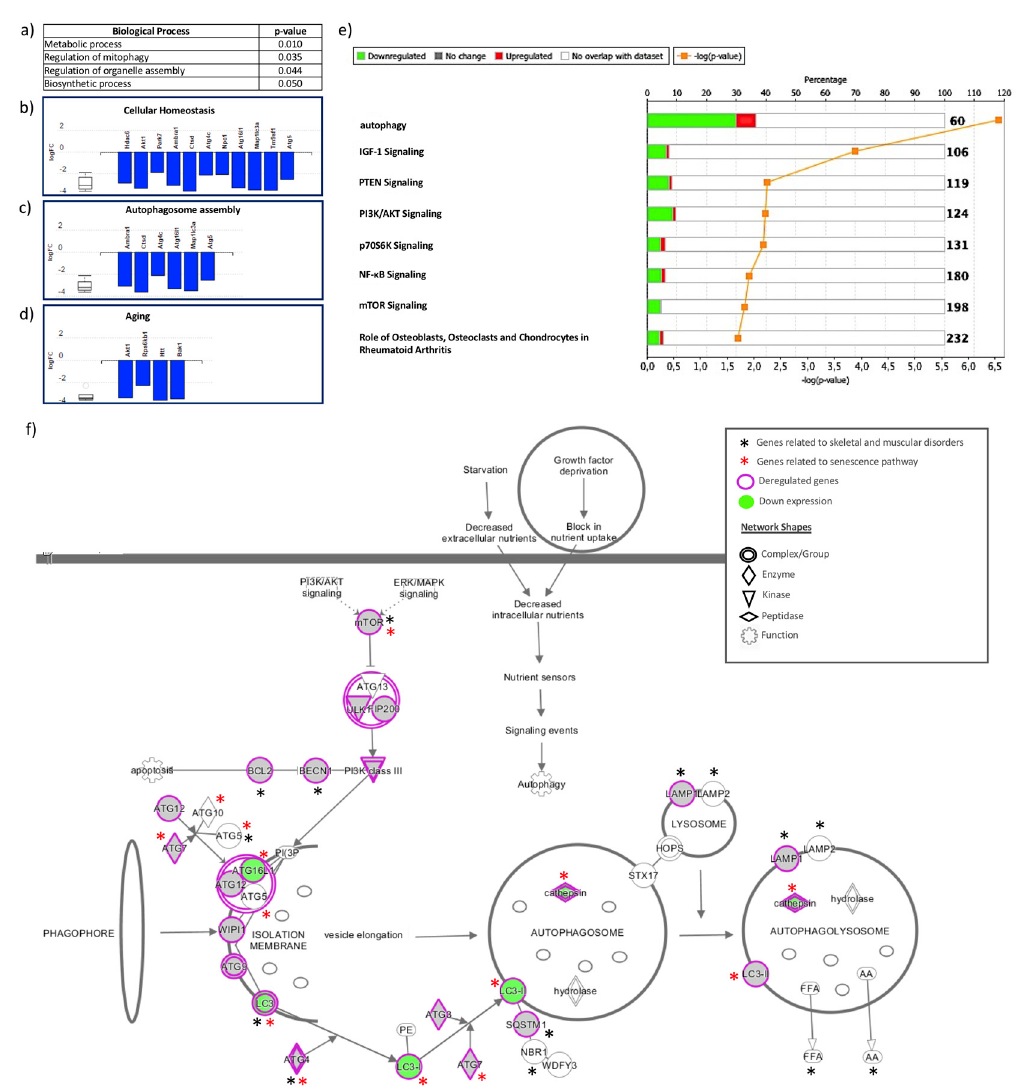
Figure 4. Bioinformatics analysis of biological process terms and pathways among genes related to autophagy in order to explore the biological relevance of the deregulated genes. ( a , d ) Bioinformatics analysis with Advaita Bio’s iPathwayGuide. ( a ) Table for biological process terms that are significantly associated with deregulated genes. ( b – d ) Molecules and their respective fold changes involved in the processes of cellular homeostasis, autophagosome assembly, and aging, respectively. ( e , f ) Bioinformatics analysis with Ingenuity Pathway Analysis. ( e ) Pathways and diseases associated with di ff erentially expressed genes. ( f ) Autophagy pathway, deregulated genes, and overlap with skeletal and muscular disorder and senescence. One of the general ways to activate autophagy begins with growth factor deprivation that blocks the nutrient uptake, and another is starvation that decreases the extracellular nutrients; both stimuli decrease the intracellular nutrients, activate nutrient sensors, and generate signaling events that empower autophagy. The detailed processes are illustrated. The upstream pathways are PI3K (phosphoinositide 3-kinase) / AKT (serine / threonine kinase) signaling and ERK / MAPK signaling, respectively, which are able to regulate mammalian target of rapamycin (mTOR) signaling, a key factor for autophagy. In general, autophagy consists of a series of dynamic membrane rearrangements mediated by a group of proteins related to ATG, where Atg1 (ULK1), Atg6 (Beclin1), Atg8 (LC3), and Atg5 are the 4 major regulators of the autophagy pathway. First, cytoplasmic sequestration is generated within double membrane vesicles called autophagosomes. Subsequently, these vesicles are fused with the lysosome to generate autolysosomes, which leads to the degradation of the cargo. It is important to highlight the association among autophagy, skeletal and muscular disorders, and senescence. The genes involved in skeletal and muscular disorders are shown with the black asterisks, and the genes related to senescence are shown with red